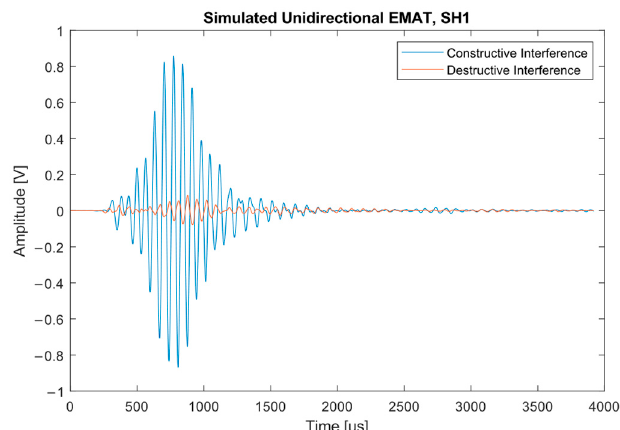
Figure 8. Signals produced by the simulated unidirectional transmitter. The dampened wave is significantly reduced in size compared to the undampened wave.